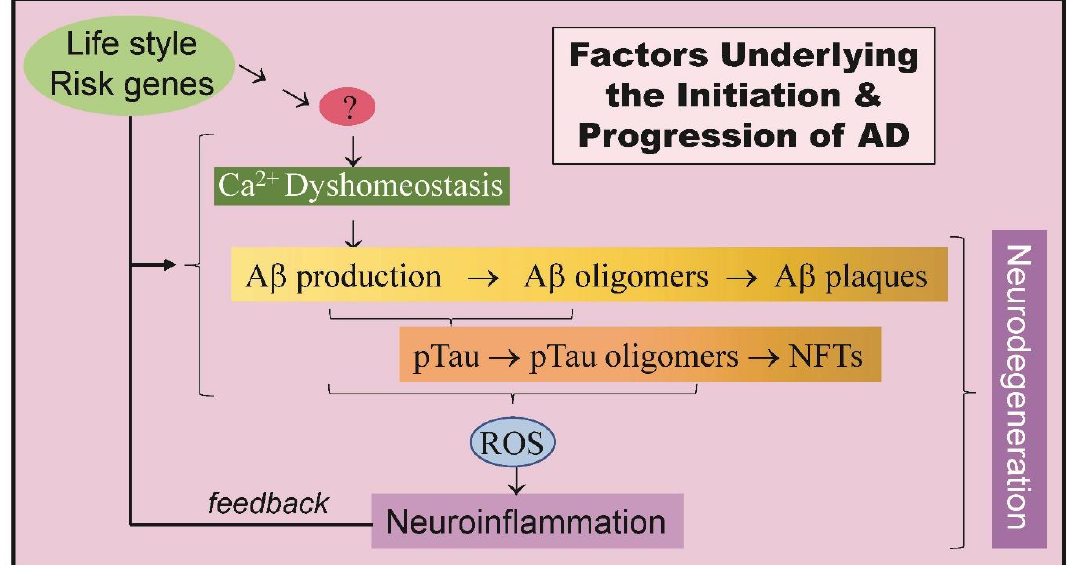
Figure 1. Factors underlying the initiation and progression of Alzheimer’s disease (AD). Lifestyle and Risk genes have a significant impact on the later development of AD but insight into how this occurs is not always clear. The initiating event(s) of AD (?) remain to be determined, but an early event is calcium dyshomeostasis that is implicated in the production of amyloid beta (Aβ) and phosphorylated Tau (pTau). Amyloid beta can form toxic oligomers that in turn can coalesce into amyloid plaques while pTau forms oligomers that form neurofibrillary tangles. These events are considered by many to lead to neurodegeneration. These, along with other events, generate reactive oxygen species (ROS) that underlies neuroinflammation an event in neurodegeneration but also one that can feedback to exacerbate or drive other events underlying AD.